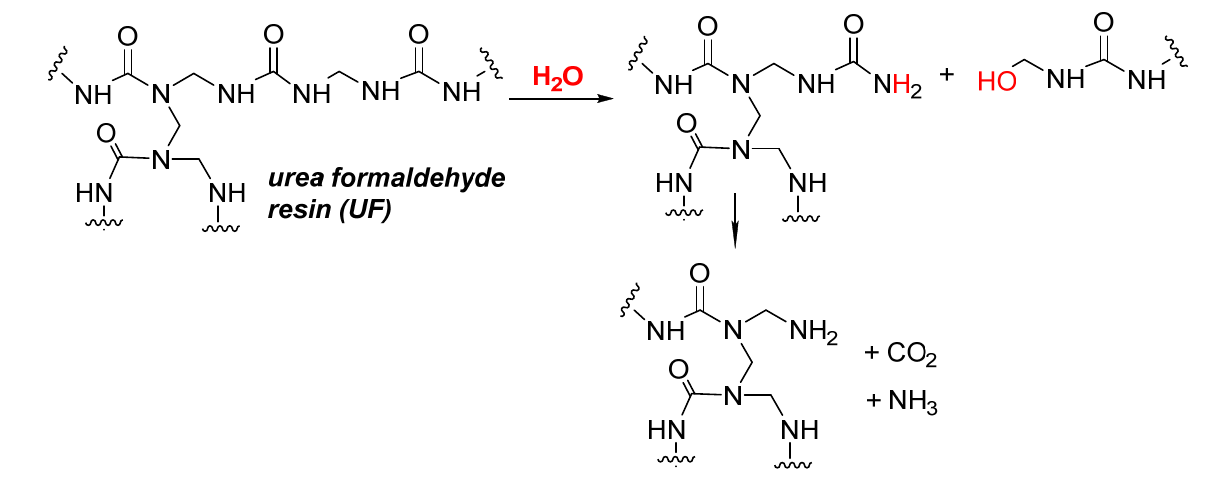
Figure 3. Chemical hydrolysis of urea—formaldehyde resin (adapted from [23]).